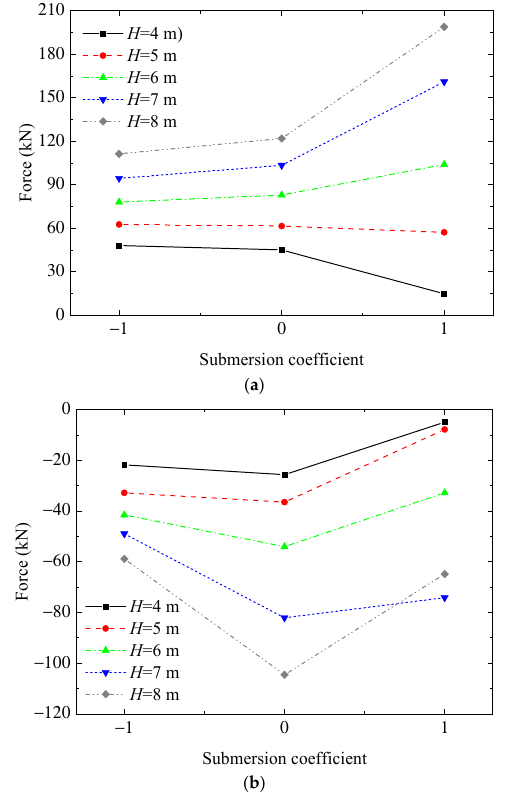
Figure 12. Comparison of the time histories of the horizontal force for Case K = 1042 kN/m. ( a ) Positive force; ( b ) Negative force.